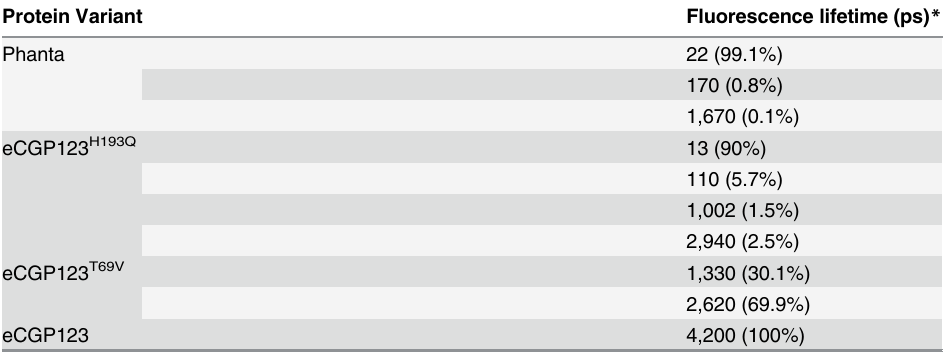
170 (0.8%) 1,670 (0.1%) 110 (5.7%) 1,002 (1.5%) 2,940 (2.5%) 2,620 (69.9%)